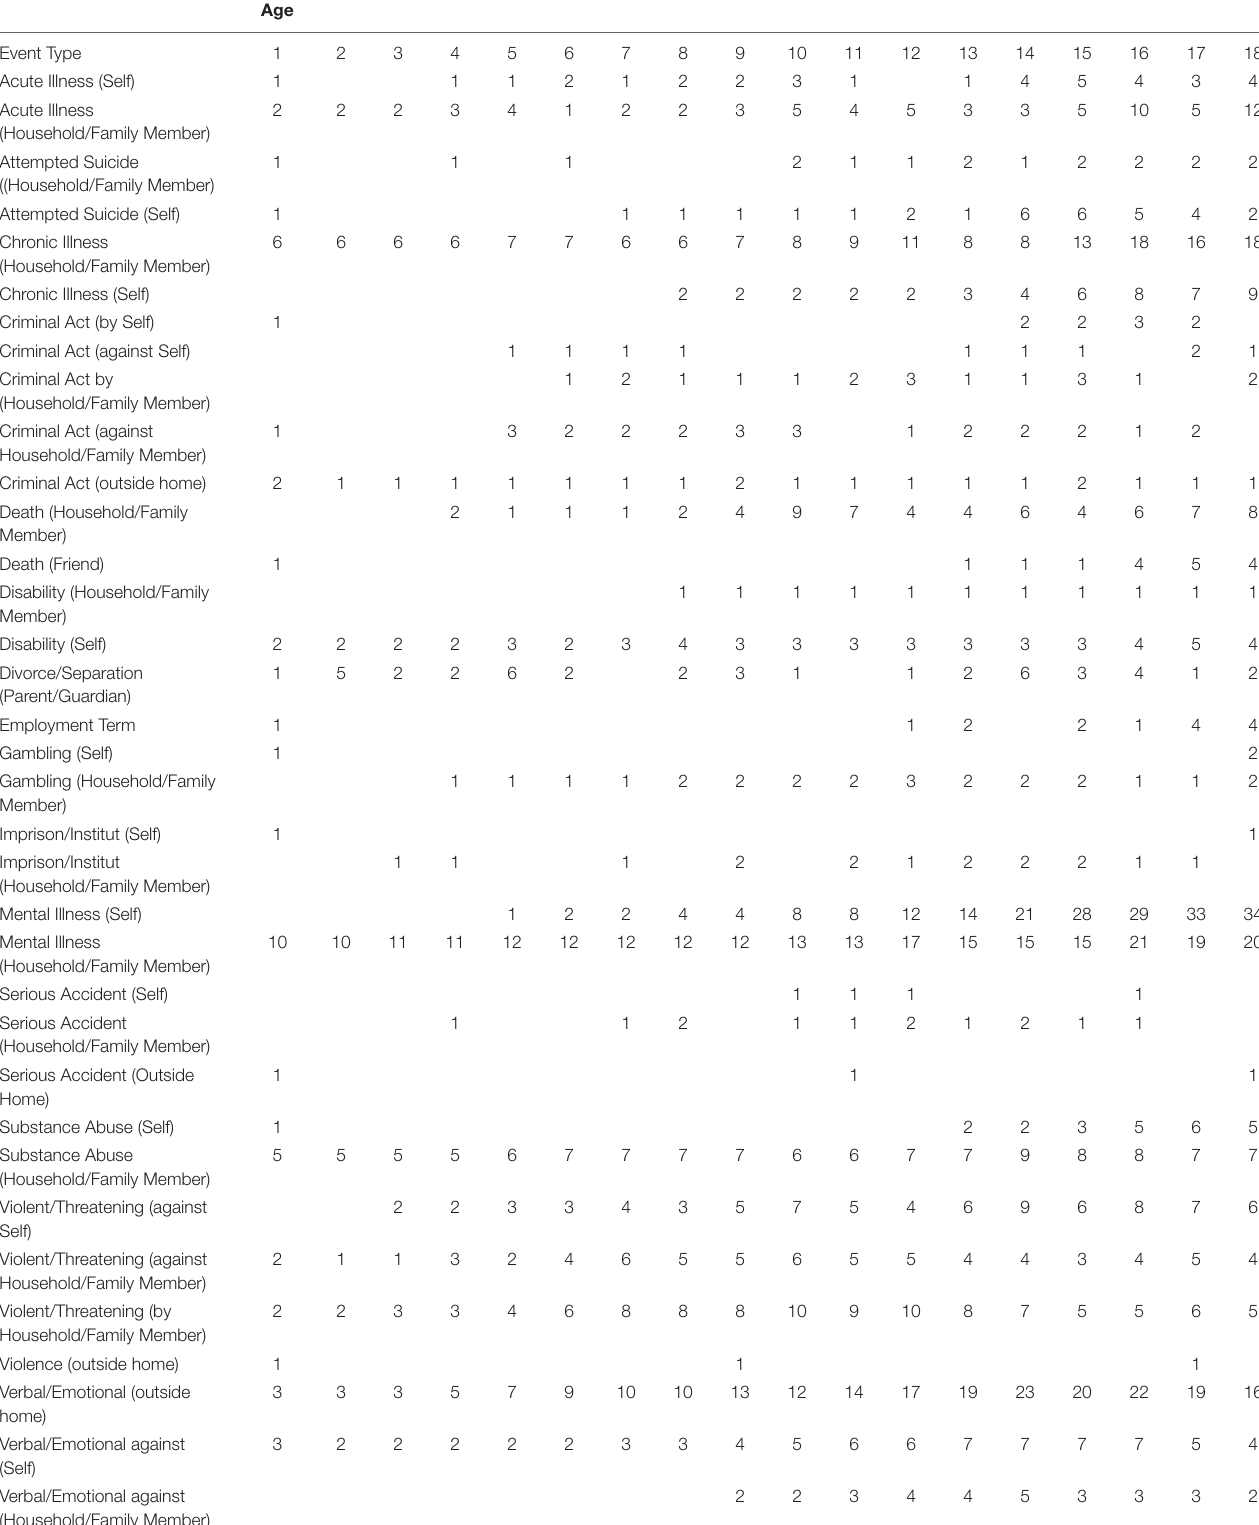
TABLE 1 | Distressing event by age